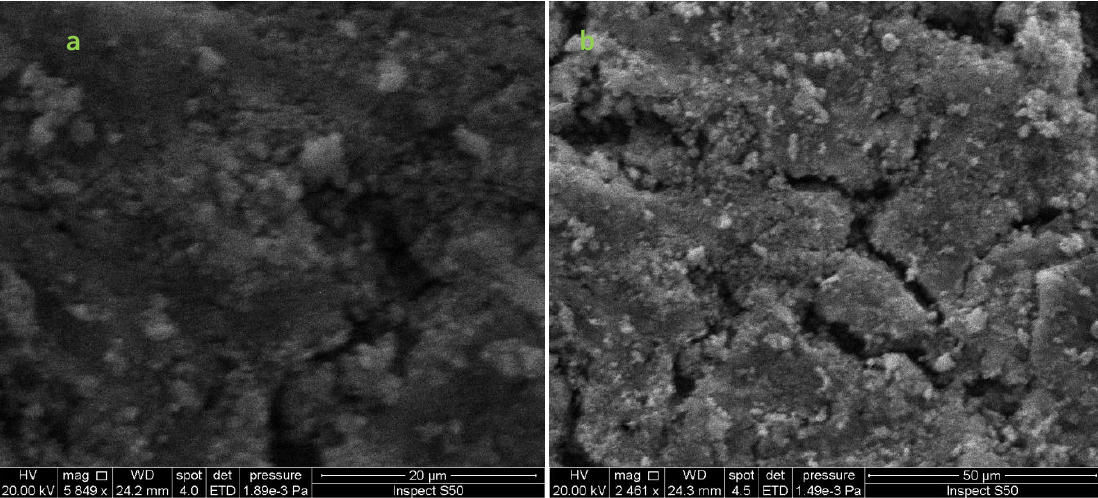
Fig. 5: SEM images for synthesized alloy NPS in water, obtained from 0.3 mm exploded FeCoSb wire at; a) high magnification, b) low magnification.